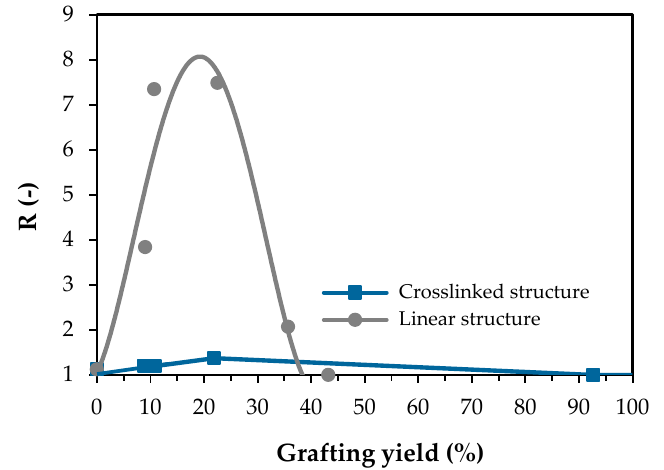
Figure 8. Effect of grafting yield on the thermoresponsive gating characteristics of PNIPAm-grafted nylon membranes of both architectures.